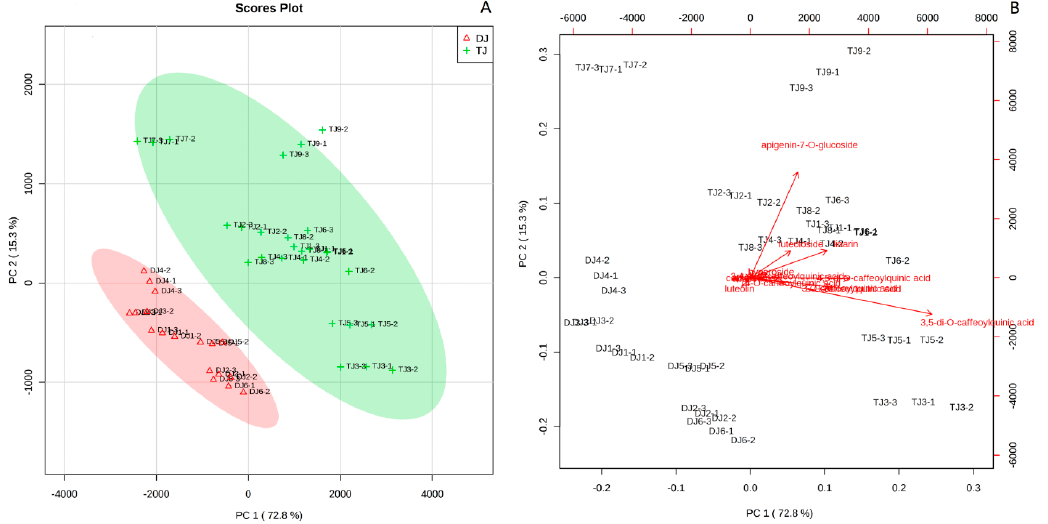
Figure 2. ( A ) Score plot of principal component analysis. DJ and TJ represent ‘Duoju’ and ‘Taiju’ samples. ( B ) Loading plot of principal component analysis. DJn-1, DJn-2 and DJn-3 represent triplicate independent experiments of DJn (n range is 1-6). TJm-1, TJm-2 and TJm-3 represent